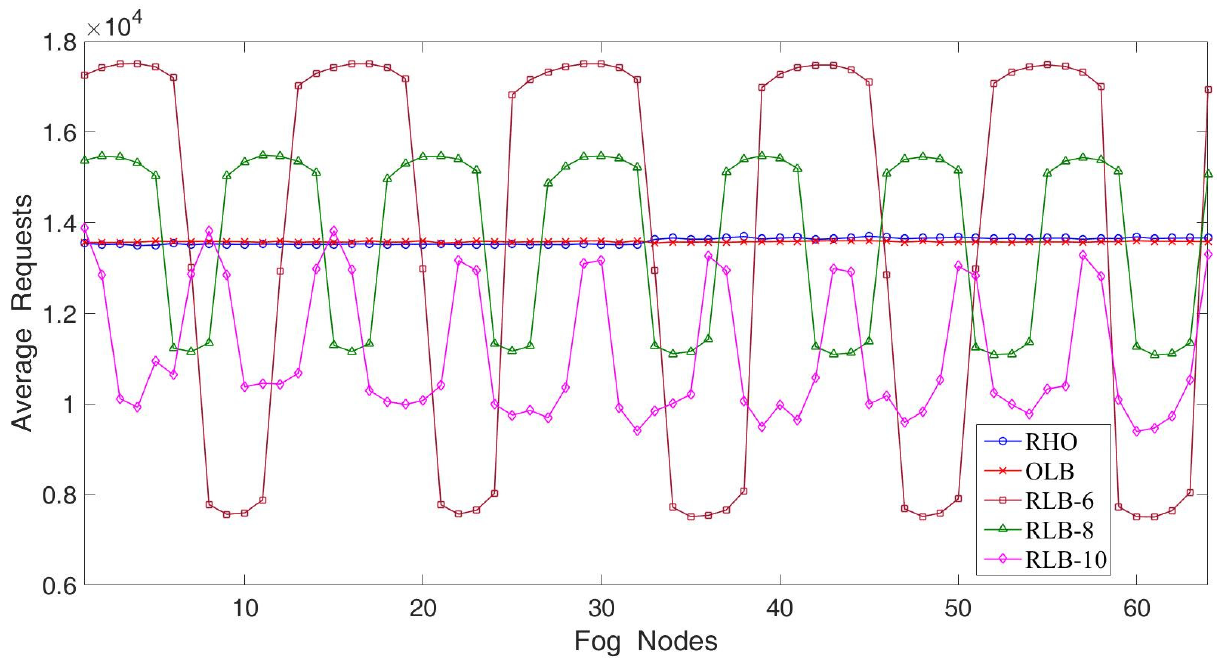
Figure 6. The average requests where sixteen fog nodes have high loads of hotspot services.